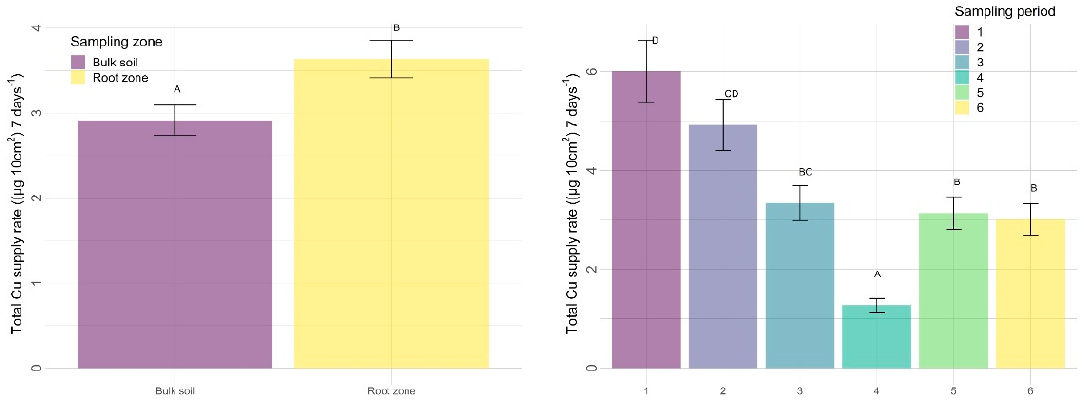
Figure 14. Cu supply rates as a function of sampling zone ( left ) and time (sampling period) ( right ). Different letters indicate significance at p < 0.05 using the post hoc Tukey HSD test.